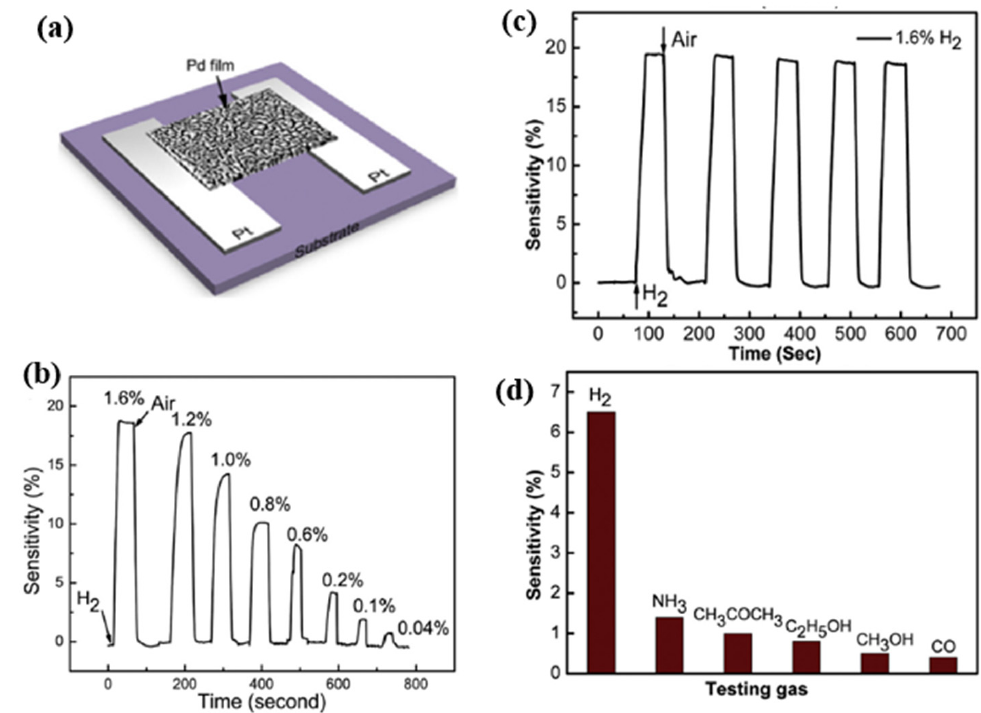
Figure 6. The hydrogen response of nanoporous Pd film sensors at room temperature. ( a ) The transient response to various concentrations of H 2 in the air; ( b ) the H2 concentration-dependent response time and sensitivity; ( c ) repeatability; ( d ) selectivity [58]. Copyright (2016), with permission from Elsevier.